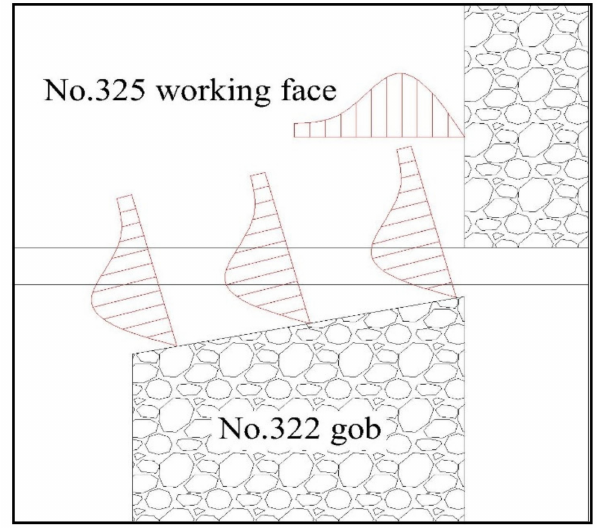
Figure 4. Schematic diagram of irregular gob structure.